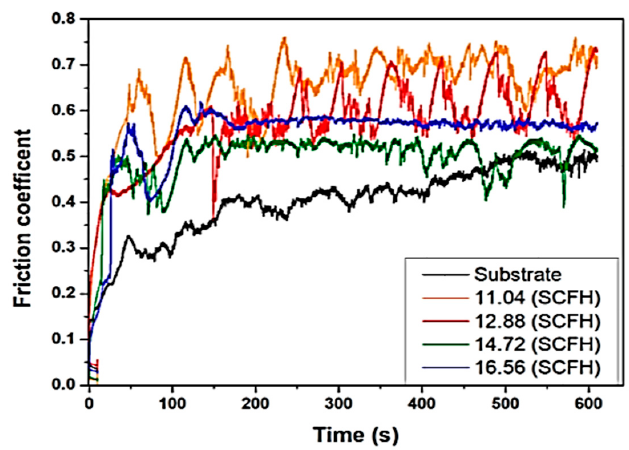
Figure 6. Friction coefficient of (COF) as a function of the time of NiTec coatings.